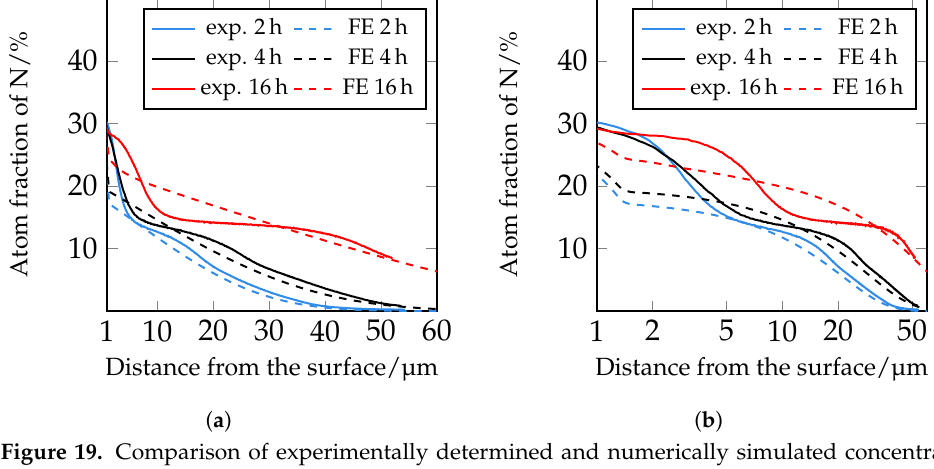
Figure 19. Comparison of experimentally determined and numerically simulated concentration profiles of nitrogen plasma nitrided at 520°C with different durations. Diffusion coefficients in mm 2 /s iteratively adjusted: D α ( b ) Logarithmic scale.